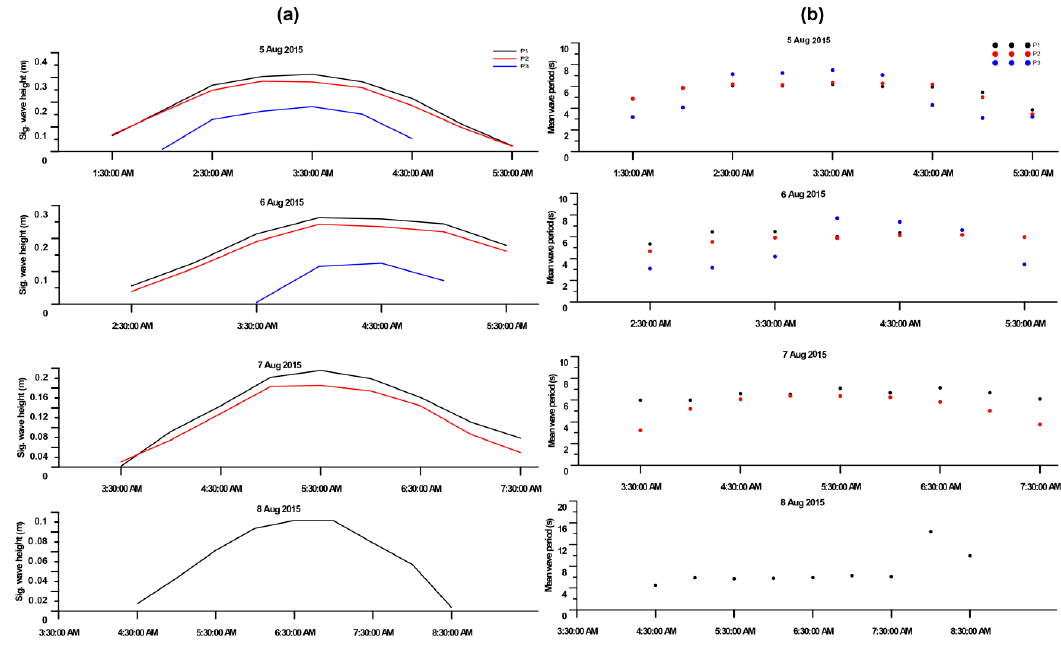
Figure 5. ( a ) Significant wave height, H s , and ( b ) mean wave period, T m , at the four measurement locations (in front of and inside the vegetation) from 5–8 August 2015.